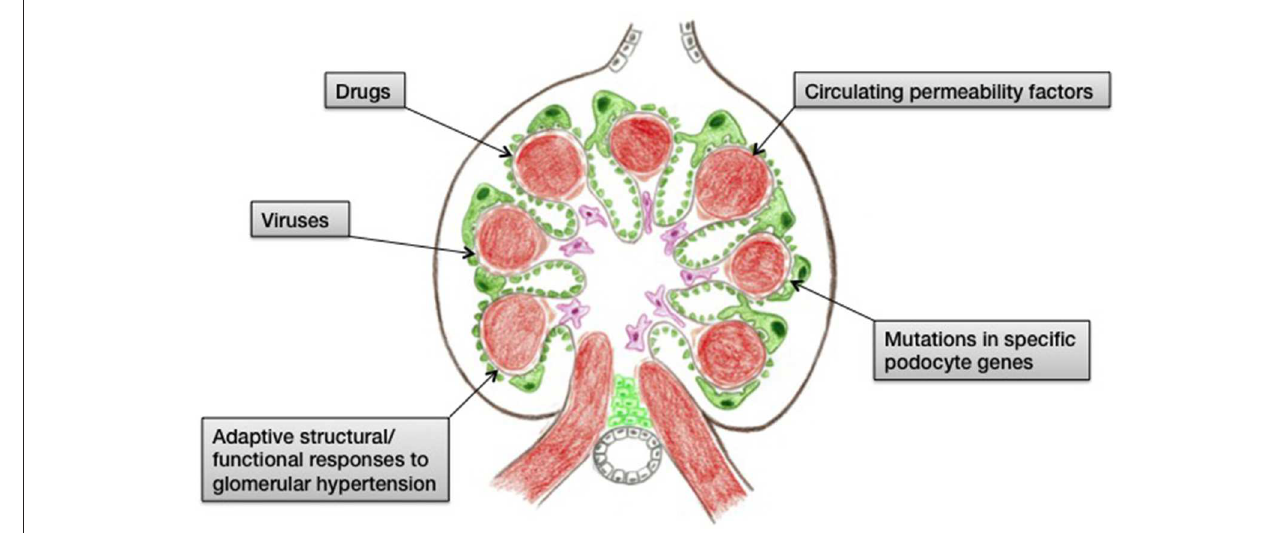
FIGURE 1 | Cartoon summarizing the causes of